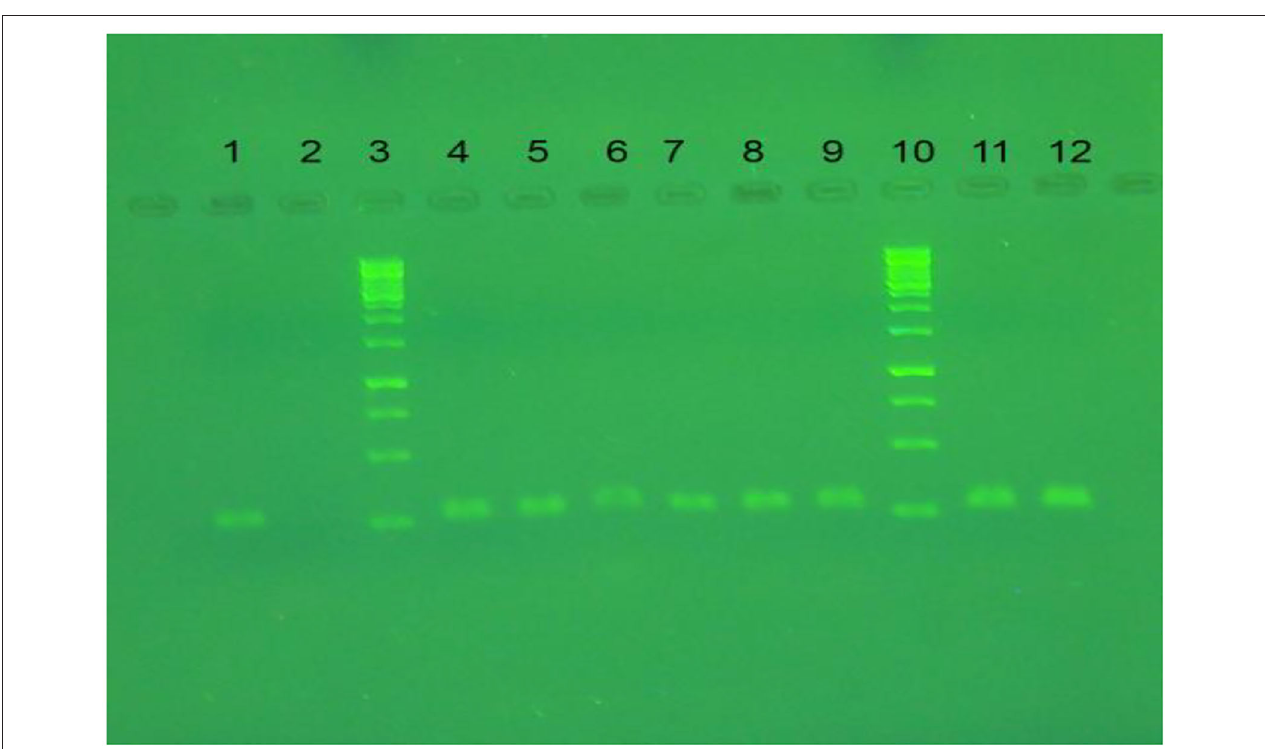
FIGURE 6 | The result of conventional RT-PCR on agarose gel. Lanes 1, 11, and 12 are RT-PCR products of LPAIV-H9N2 via specific primer for H9 gene. Lanes 3 and 10 are DNA ladder (SM0313). Lane 2 is a negative control, lanes 4-9 are RT-QPCR products for H9N2 cDNA dilution (10 − 1 -10 − 3 ) in